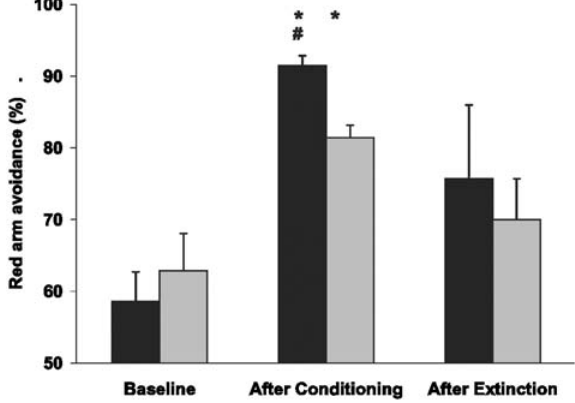
Figure 12. Generalization of red color avoidance in the T-maze condition, following training in negative reinforcement paradigm in young and middle-aged zebrafish. Y-axis: % time young (black) or middle-aged (gray) zebrafish spent outside red color zone of the tank at Baseline, following Conditioning or Extinction phases. *p , 0.001, relative to